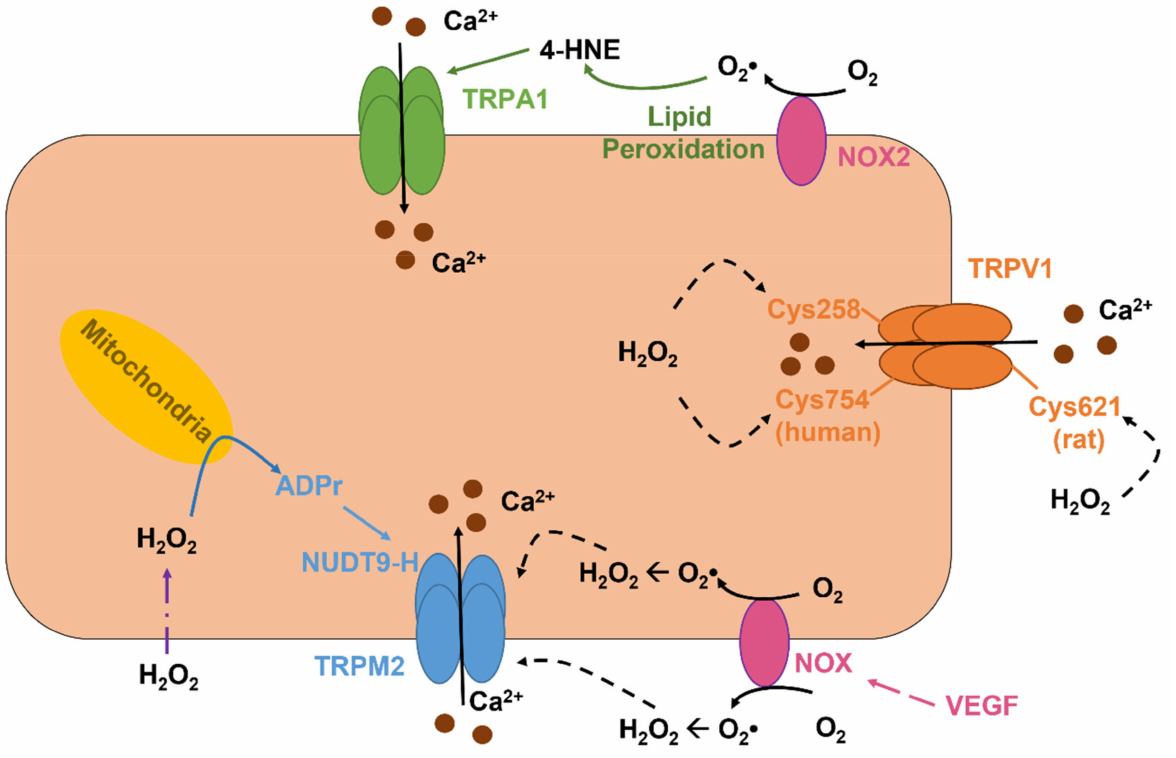
Figure 3. ROS activate endothelial TRPA1, TRPV1, and TRPM2. H 2 O 2 may directly activate TRPV1, although the underlying mechanism may vary depending on the species and involves the cytosolic Cys258 and Cys274 and the extracellular Cys621 in the human and rat proteins, respectively (please see the text for further explanation). H 2 O 2 may indirectly activate TRPM2 by inducing the mitochondrial production of ADPr, which binds to the COOH terminal NUDT9-H motif and gates the channel. VEGF-induced NOX2 activation may lead to TRPM2 activation upon intracellular ROS production. NOX2-derived O 2 • − may induce lipid membrane peroxidation and thereby promote 4-HNE formation through the Fenton reaction. 4-HNE, in turn, stimulates TRPA1 to mediate extracellular Ca 2+